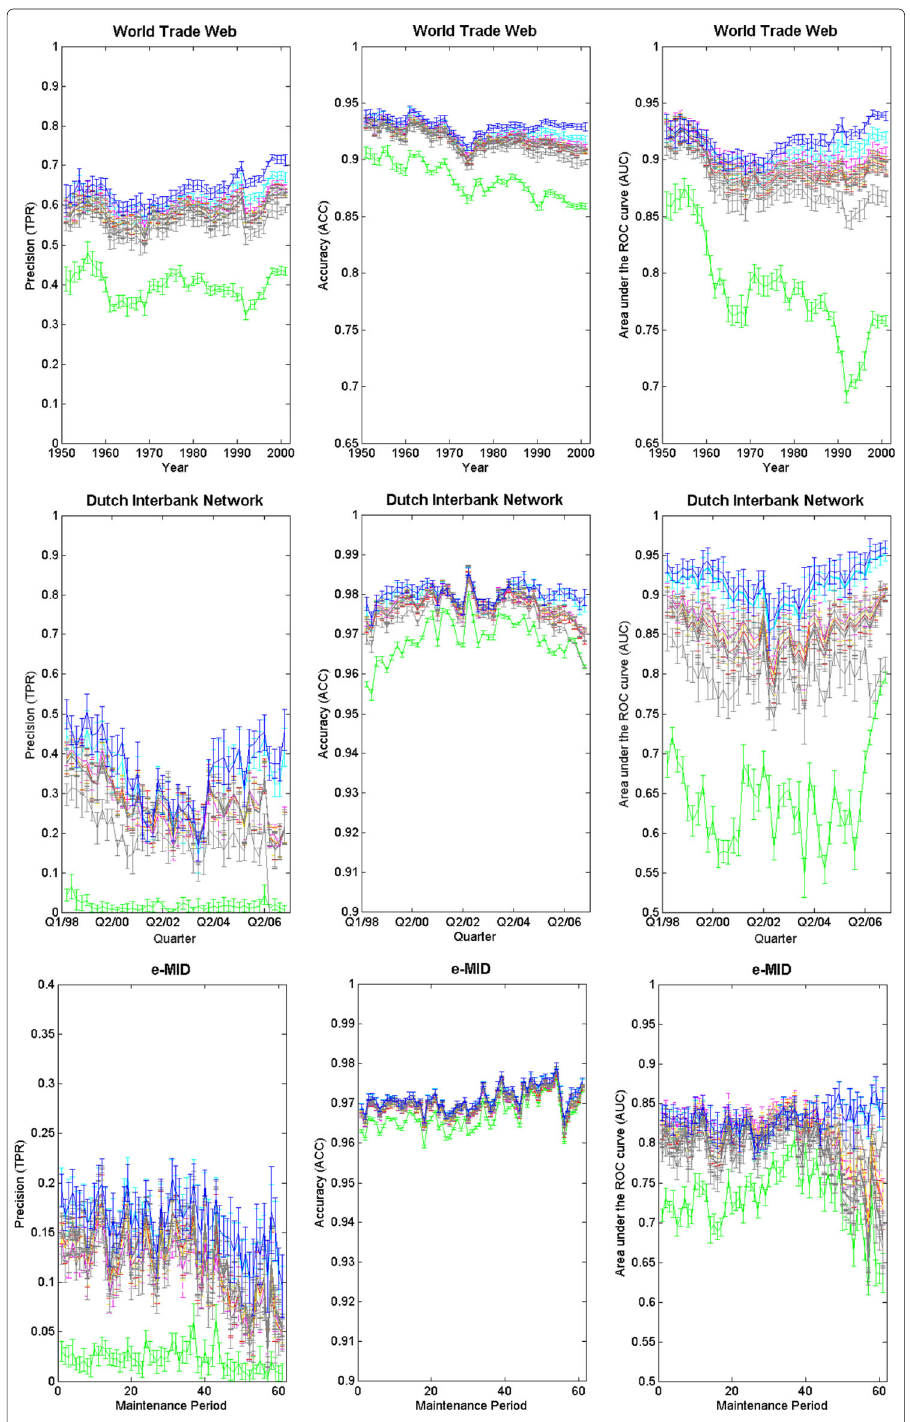
Fig. 4 Error bars accompanying the estimation of the link-prediction algorithms shown in Fig. 1. Panels refer to the undirected version of the WTW (top), the DIN (middle) and e-MID